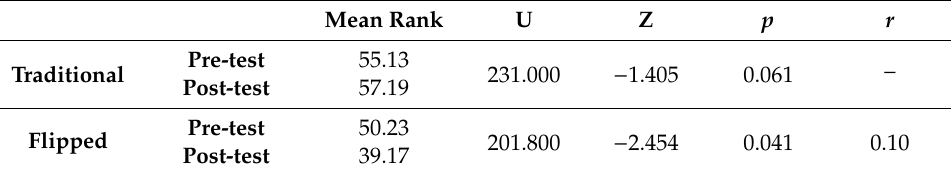
Table 5. Mann–Whitney U test for learning anxiety dimension.